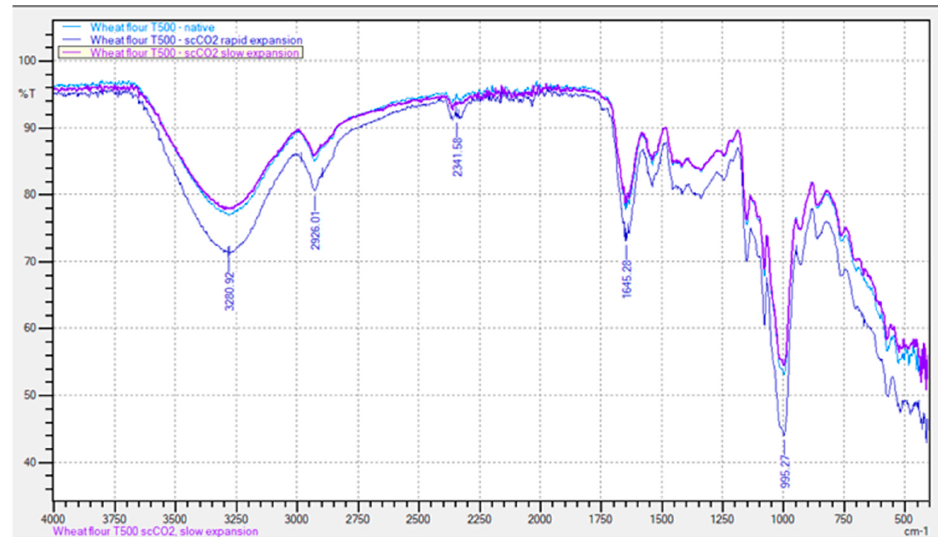
Figure 5. Comparison of the FTIR spectrum for non-treated and scCO 2 -treated wheat flour T500 with slow and rapid expansion of CO 2 .